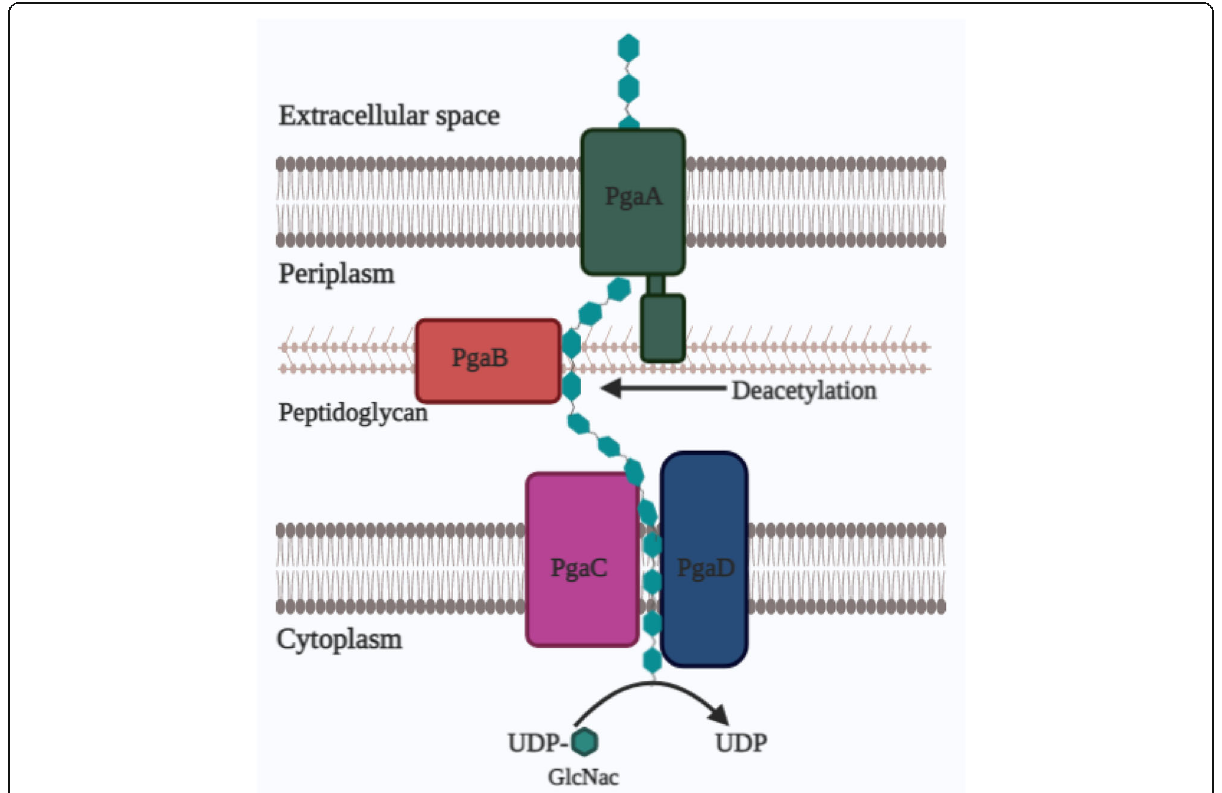
Fig. 2 Biosynthesis of PNAG polysaccharide using pgaABCD